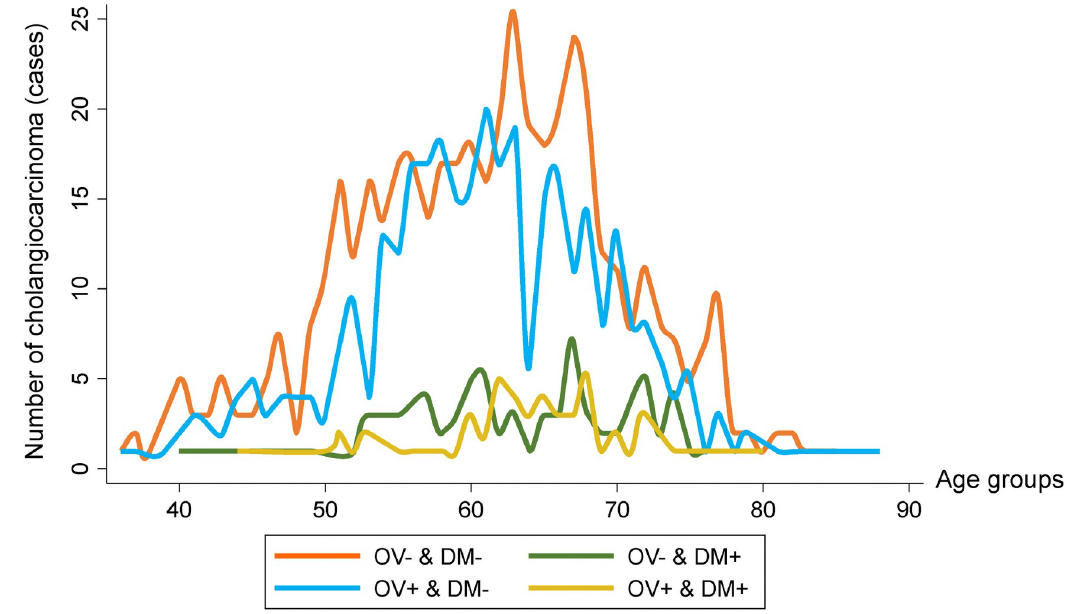
Fig 5. Numbers of cholangiocarcinoma cases by age and in relation to O . viverrini infection and diabetes mellitus status. Data shows the number of cholangiocarcinoma cases according to combination of O . viverrini infection and diabetes mellitus according to age in